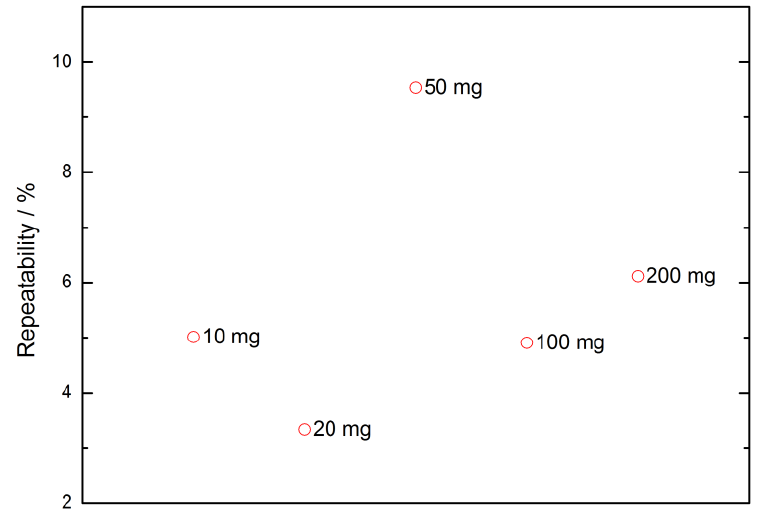
Figure 3. Relative repeatability (standard deviation).